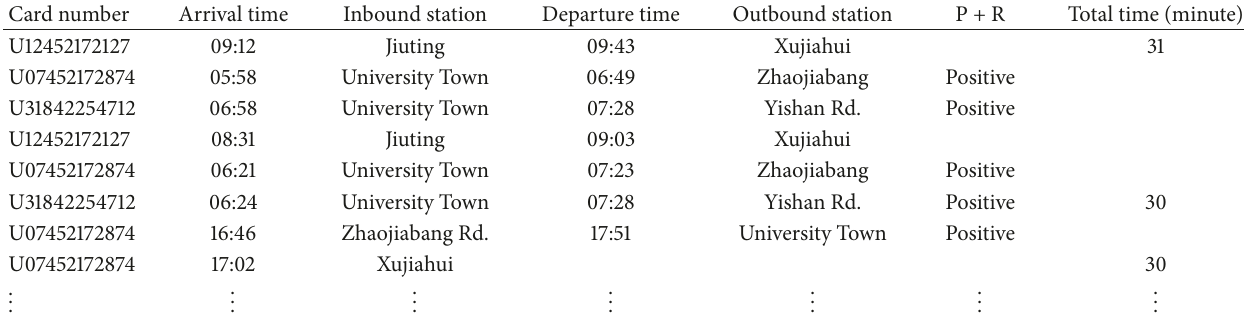
Table 1: The AFC passenger flow data of Shanghai Metro Line 16